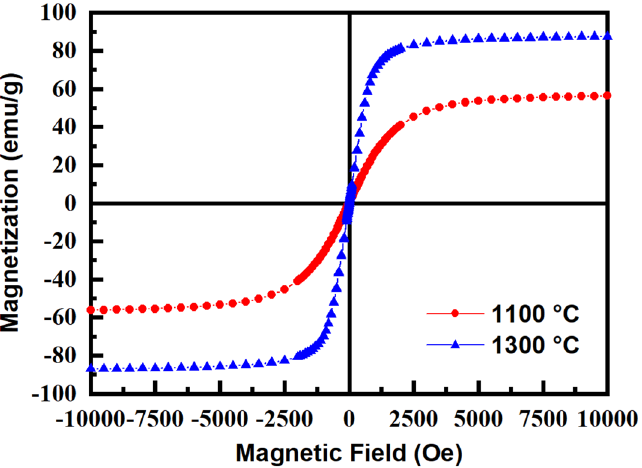
Figure 6. Magnetic hysteresis curves of the samples sintered at 1100 and 1300